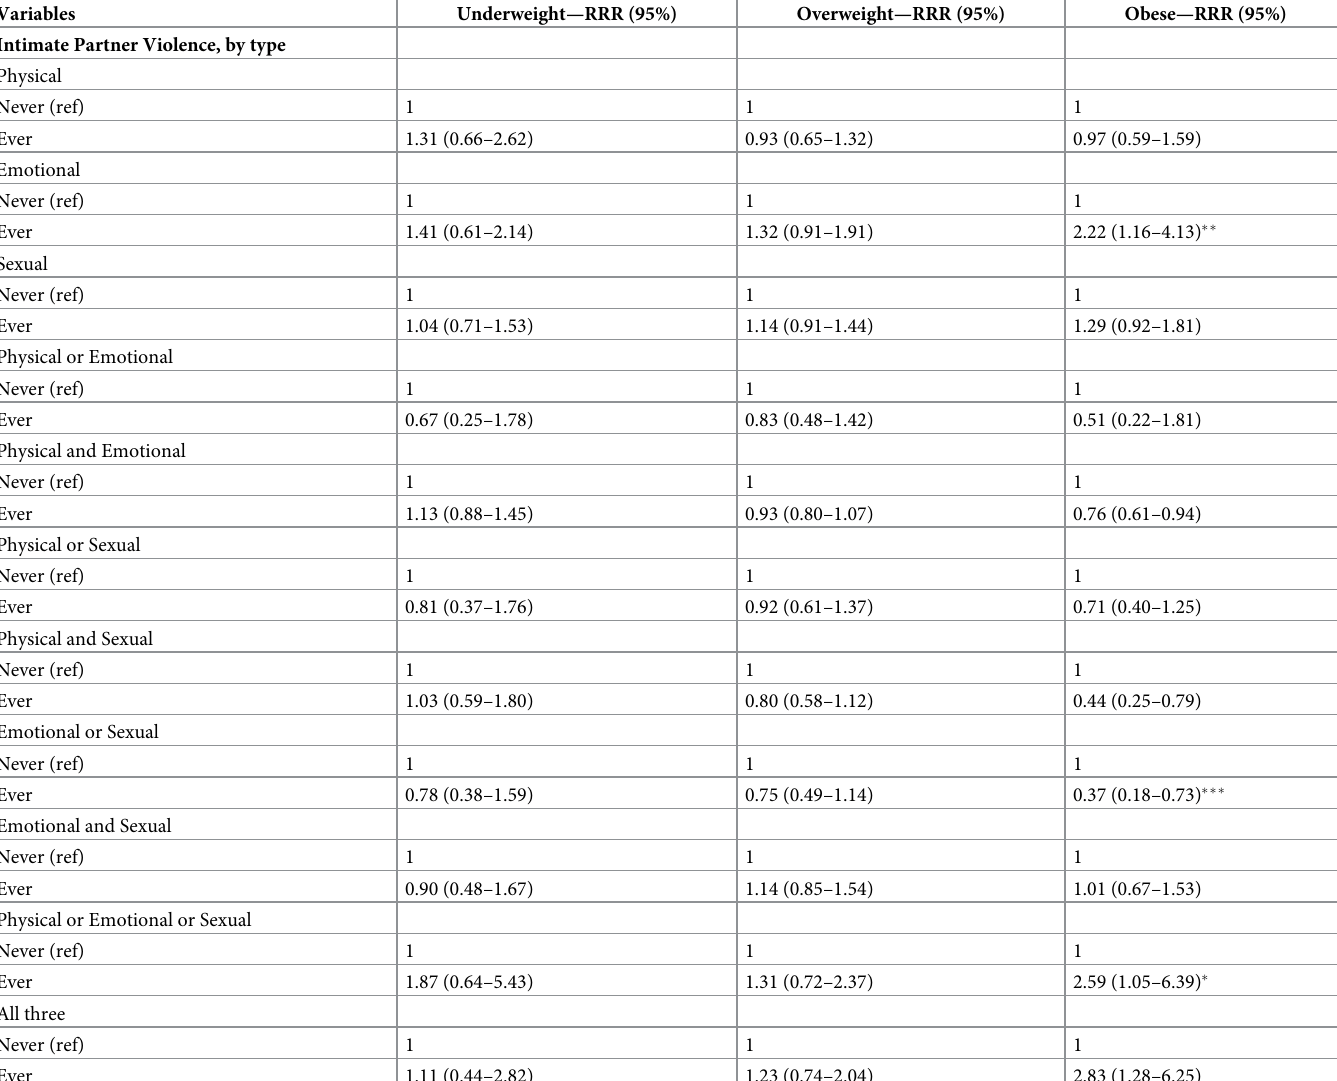
Table 3. Multinomial logistic regression of the association between intimate partner violence and nutritional status of women (15–49 years), Zimbabwe, pooled data, 2005–2015.